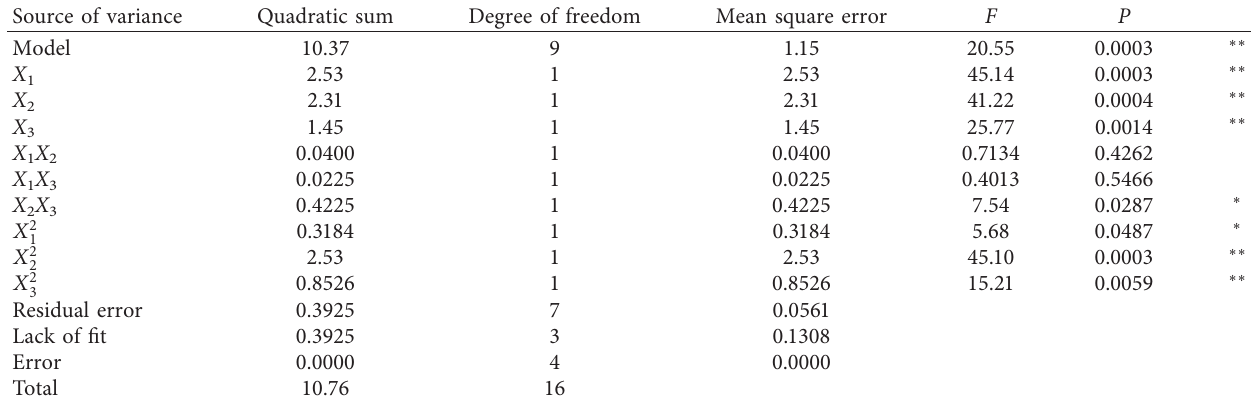
Table 5: Variance analysis of missing index.